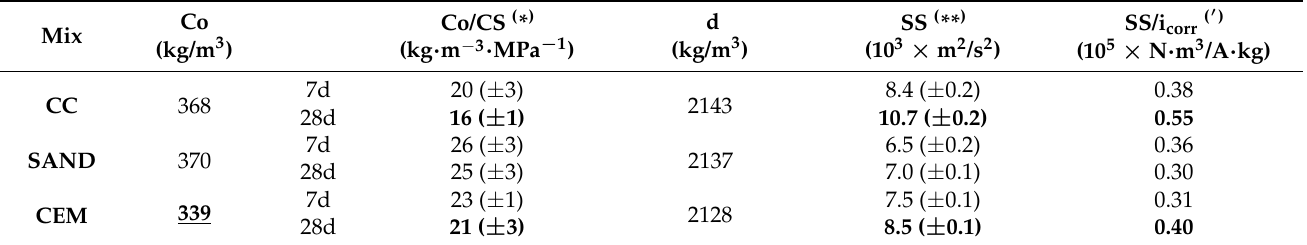
Table 6. The values of the consumption of cement (Co), the Co per compressive strength (CS), the specific mass (d), the determined specific strength (SS) per (d) and SS per icorr at 7 and 28 days for the CC, SAND and CEM samples